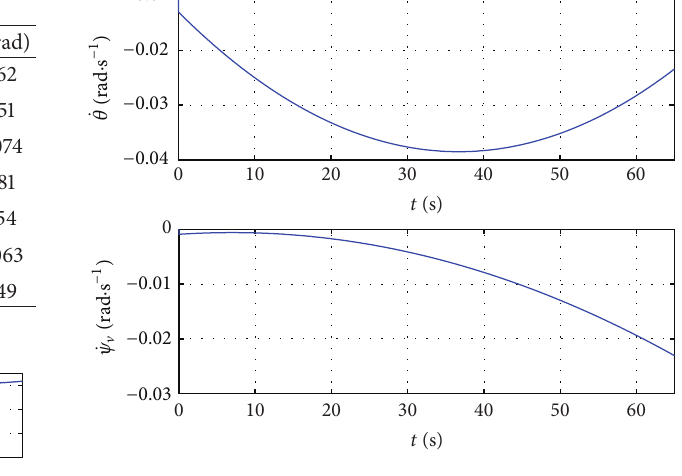
Figure 4: The changing rate of the trajectory angles.